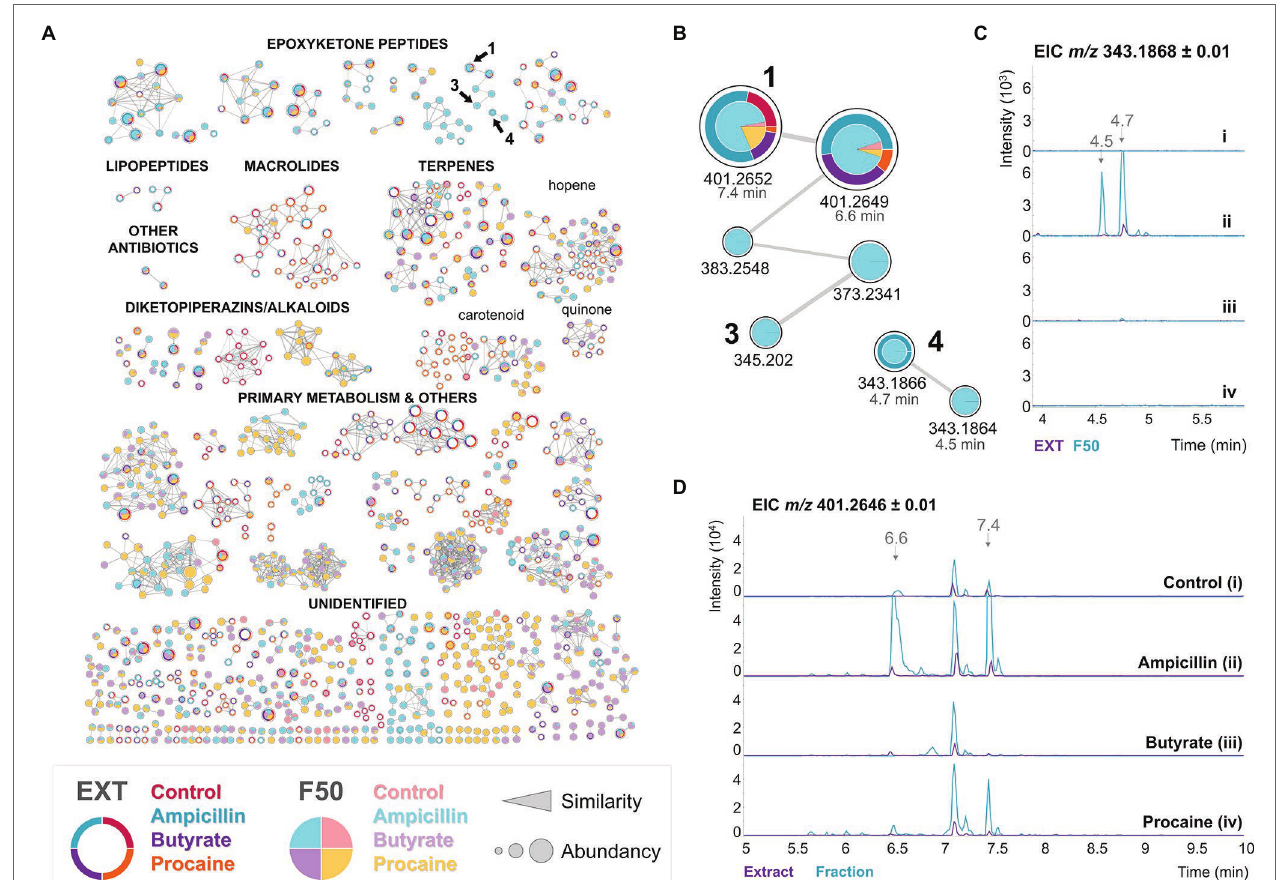
FIGURE 3 | Chemical elicitors, especially ampicillin, induce the production of epoxyketone peptides by BRA-346. (A) SSMN of BRA-346 cultures using the A1 medium and different chemical elicitors [no elicitor, as a control, (i); ampicillin 100 μ g/ml (ii); sodium butyrate 50 μ M (iii); procaine 100 μ M (iv)]. Only the [M + H] + spectra and nodes with at least one connection are shown for clarity. In each node, the external ring chart represents the crude extracts, and the internal pie chart represents the F50 (50% methanol) fractions. (B) Detail of the epoxyketone MS/MS clusters containing compounds 1 , 3 and 4 . (C) and (D) represent the EIC of m/z 343.19 ± 0.01 (TMC, 4 ) and m/z 401.26 ± 0.01 (DHE, 1 ), respectively. Chromatograms of the crude extract and F50 fractions samples are represented in purple and cyan,